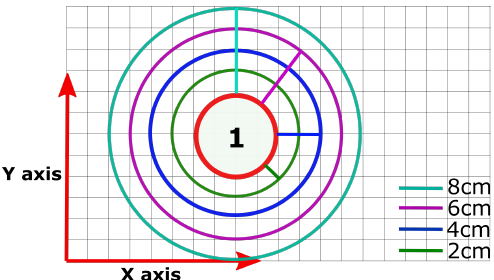
Figure 6. The settled margin of radius error for object’s location. The largest range was chosen to be coincident with the palm-to-wrist length of the 99% of adults, corresponding to 8 cm [42].